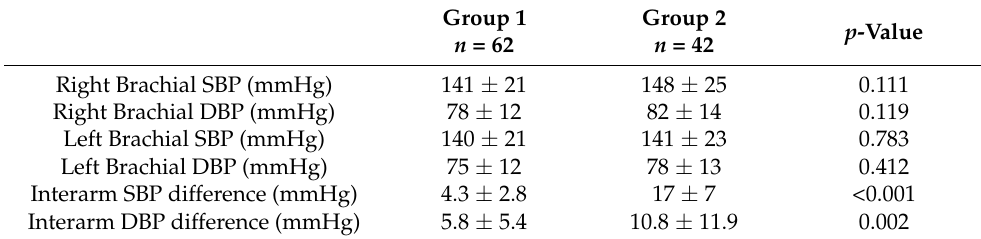
Table 2. Blood Pressure Measurement Values of Both Groups.